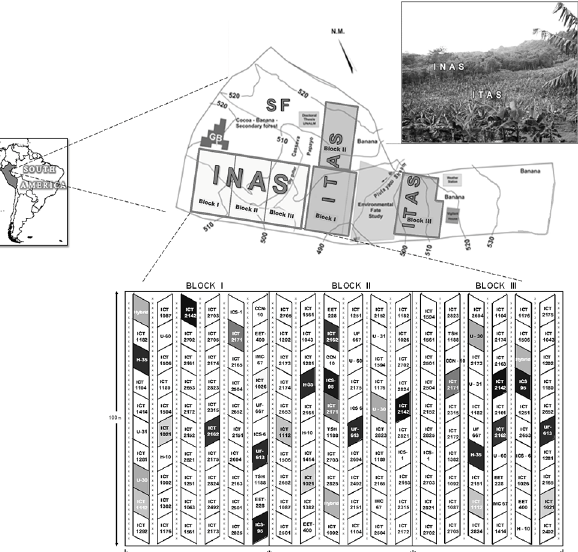
Fig 1. Map Showing the Location of Cacao Agroforestry Management Field Study (INAS, ITAS).